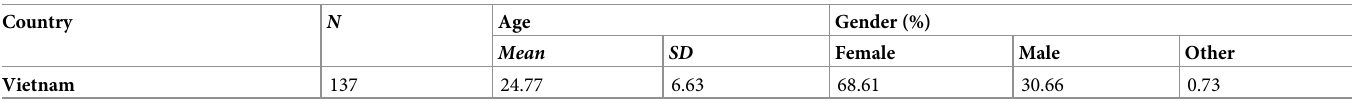
nization (WHO), (6) their country’s government’s effort to handle the Coronavirus. Compliance with local prevention guidelines. Participants indicated their agreement, on a 6-point Likert scale (1 = strongly disagree, 6 = strongly agree) with the statement “I have done everything I could possibly do as an individual, to reduce the spread of coronavirus”.